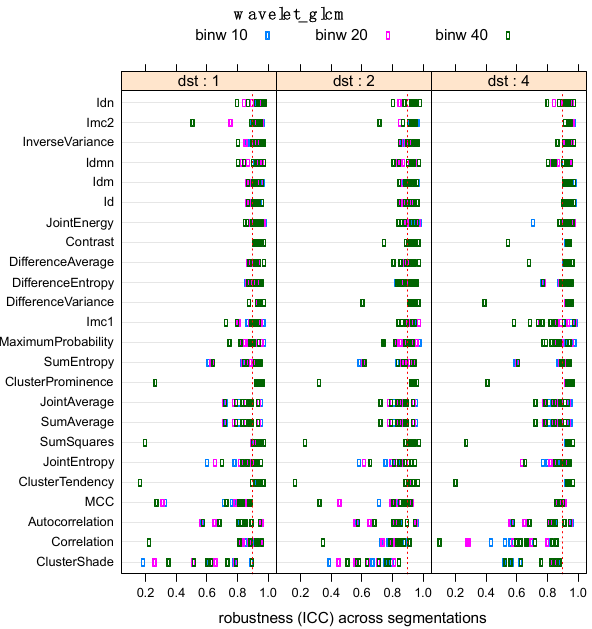
Figure 9. Robustness of wavelet-based first-order histogram features across segmentations. The vertical dashed red line indicates the ICC > 0.9 threshold. Pyradiomics provides 18 first-order features. The robustness (ICC) is above 0.8 only for Skewness, Kurtosis, Uniformity and 90Percentile. The latter has ICC > 0.90. They are not much dependent on bin-width (only entropy and uniformity have slight dependence). Because they are first-order, they are not dependent on distance neither do they depend on resolution or interpolator. However, the wavelet features are dependent on the direction used for wavelet computation (each circle on a line is a different gradient direction).